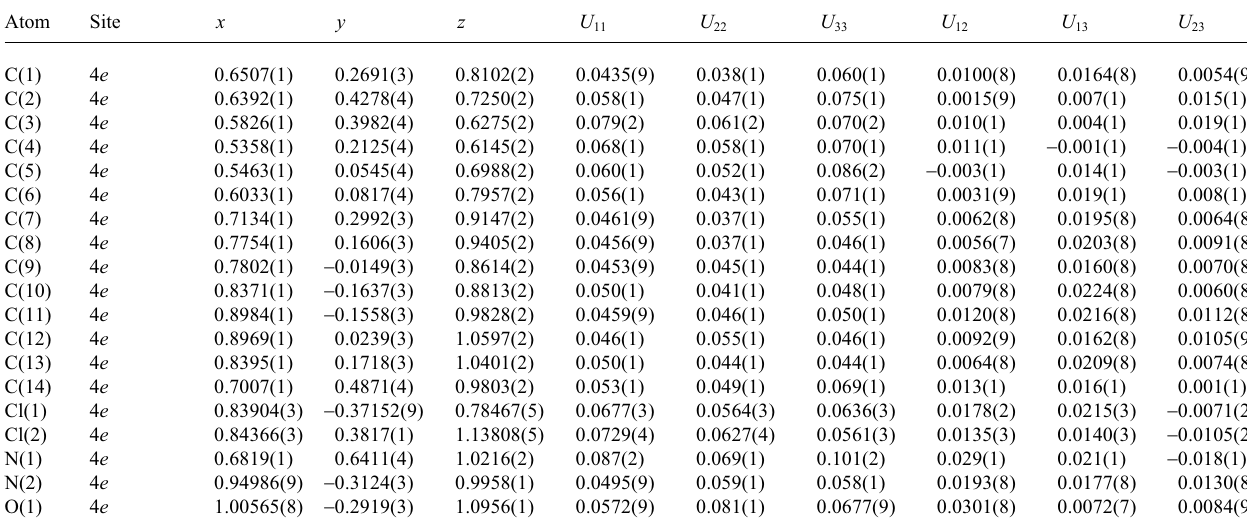
Table 3. Atomic coordinates and displacement parameters (in Å 2 )